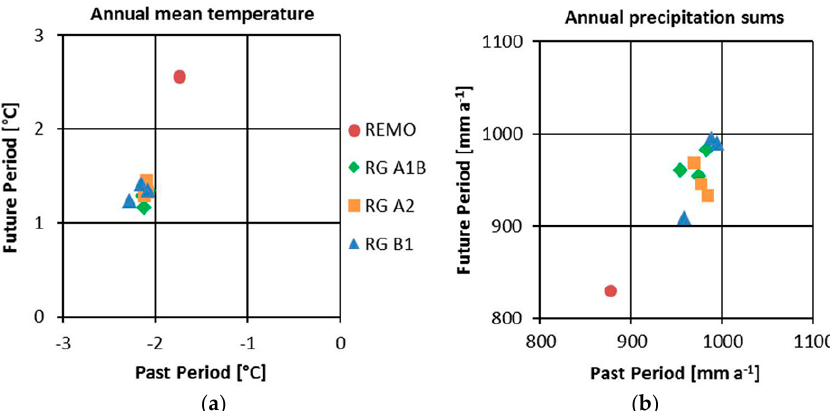
Figure 4. Annual mean temperature ( a ) and annual precipitation sums ( b ) of the Past and Future Periods.